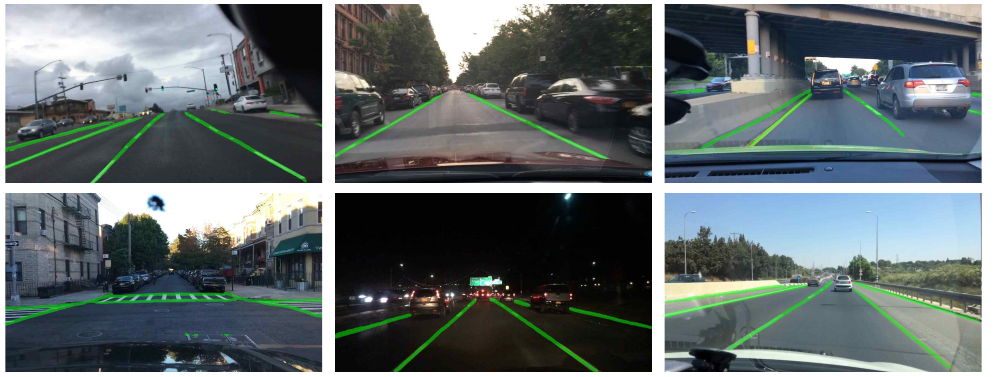
Figure 4. Examples of the lane line segmentation results.